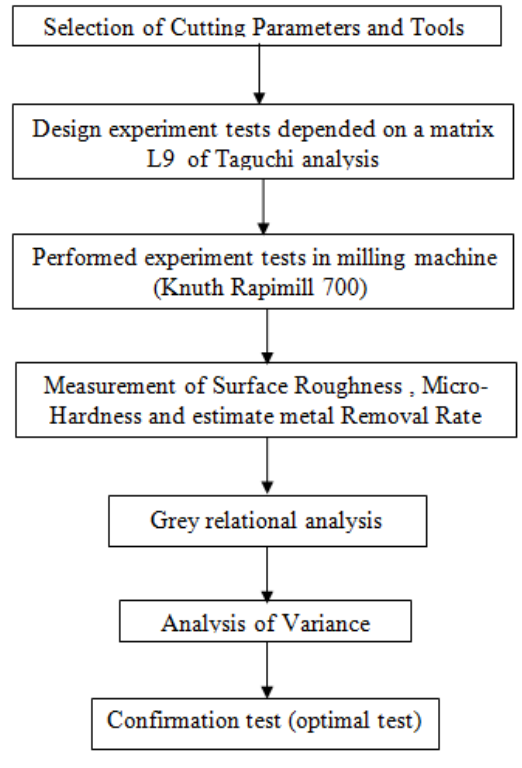
Fig. 4. Flow chart of work